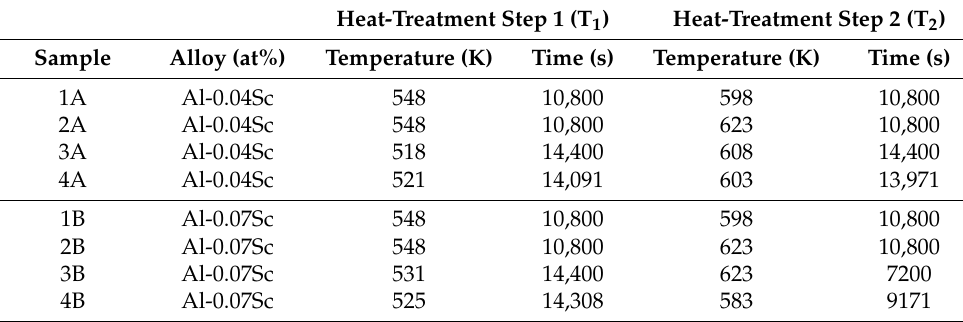
Table 2. Heat-treatment parameters of calibration experiments.